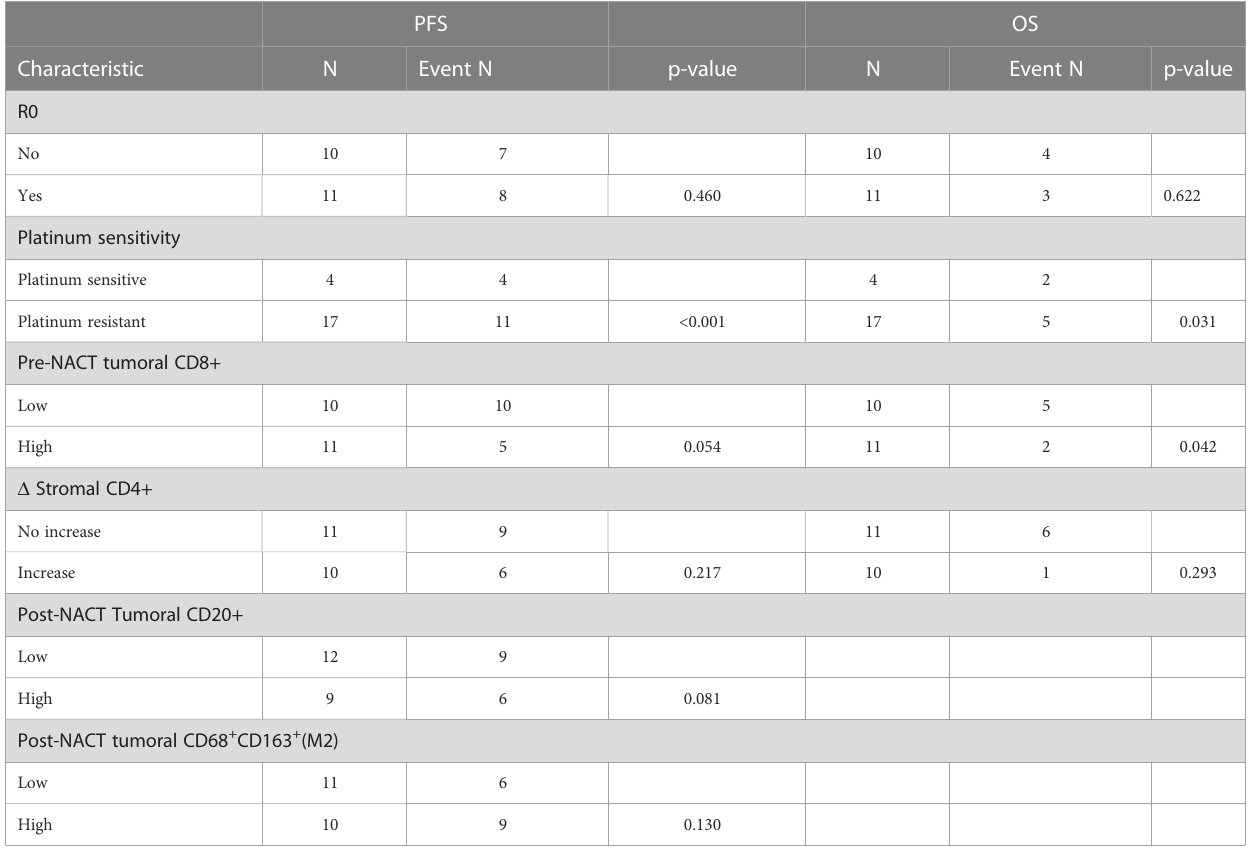
TABLE 3 Multivariate cox regression analysis of potential risk factors in pre- and post-NACT paired